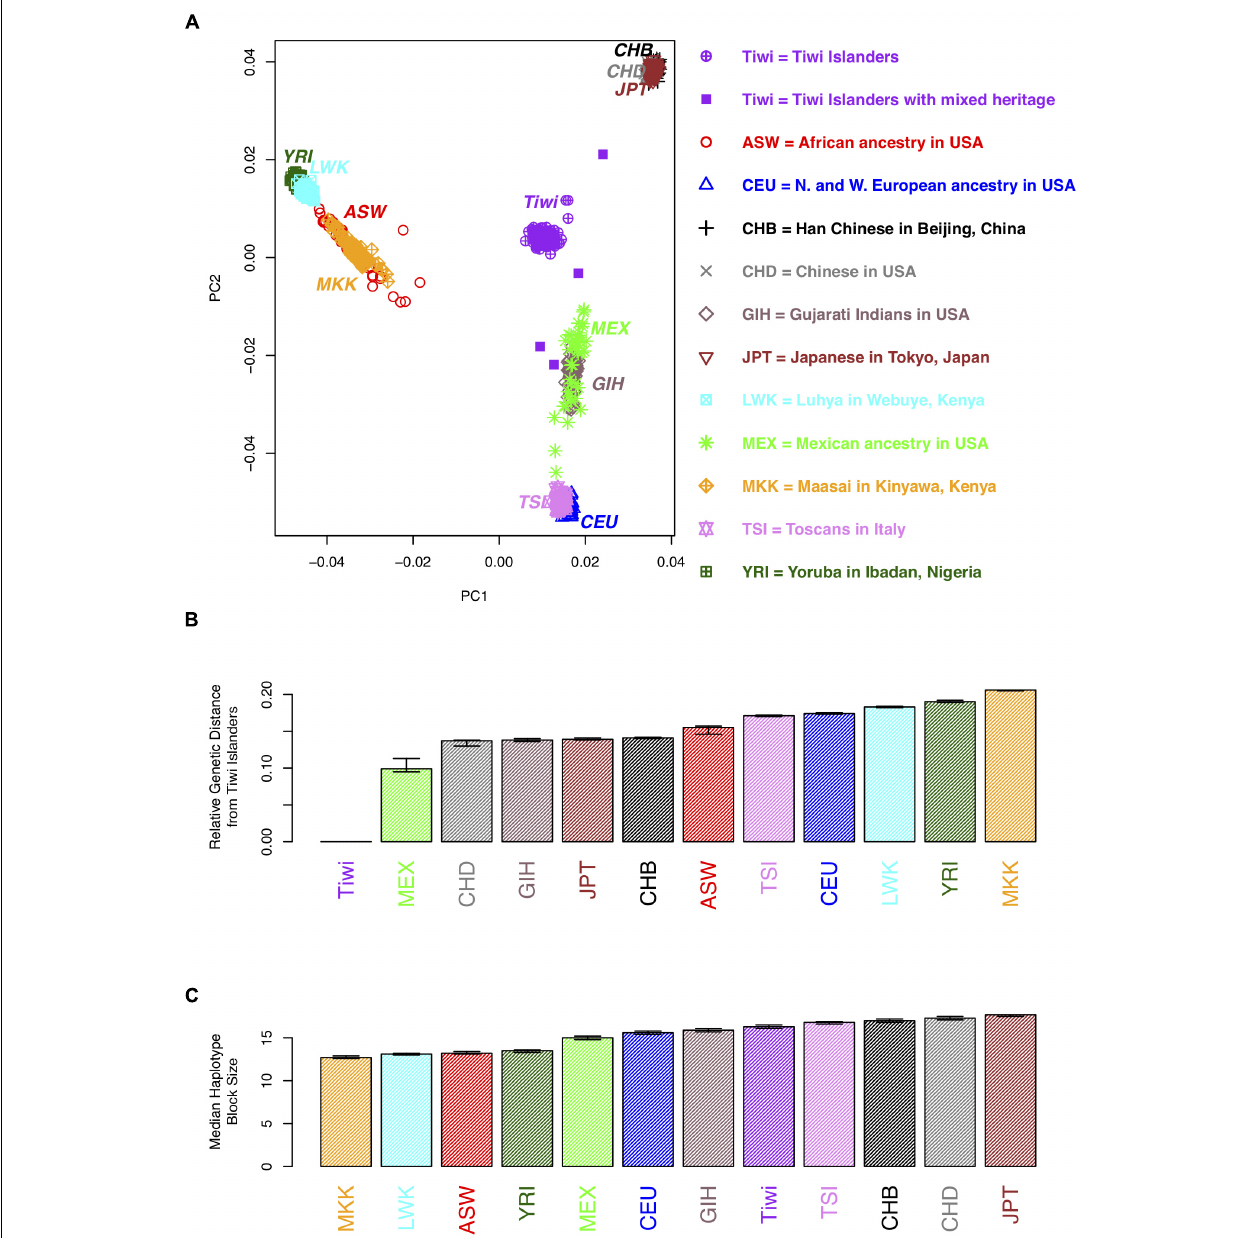
FIGURE 1 | Population genetic analyses of 73 unrelated individuals from the 249 Tiwi cohort from the 1990s. (A) A plot of the first two principal components (PCs) for an analysis of the hapmap3 samples from 11 populations and the Tiwi cohort. Each point represents an individual. More distant points are more genetically distinct. Tiwi study participants that self-reported as mixed heritage are indicated by opaque purple squares. (B) The genetic distance between the midpoints of each of the hapmap3 samples and the Tiwi samples was calculated using all principal components. (C) The median haplotype block size of the hapmap3 samples from 11 populations and the 1990s Tiwi cohort. Haplotypes were defined using software Haploview based on the four gamete rule ; 95% confidence intervals, estimated using bootstrap sampling, are displayed for the estimates in B and C .